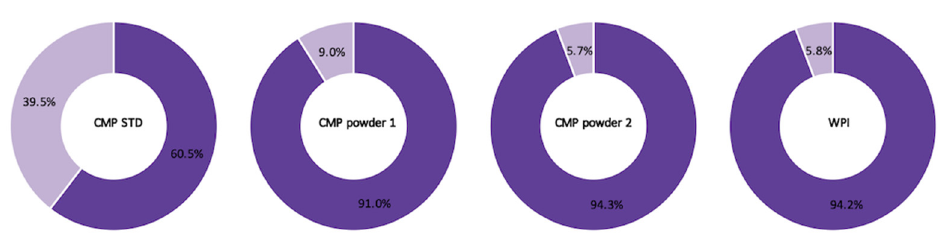
Figure 4. The relative abundances of intact CMP with CMP A (purple) and CMP B (light purple) sequence in the four samples (CMP STD, CMP powder 1, CMP powder 2 and WPI).